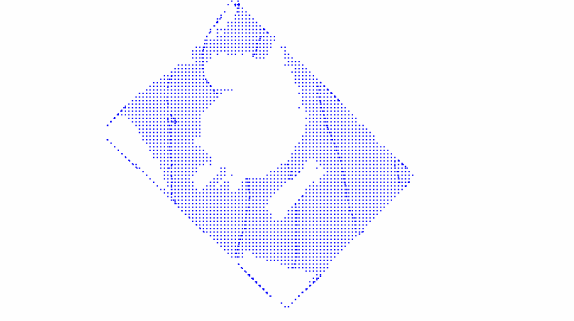
Figure 4: Raw ensemble of inliers, orthogonal projection on the ceiling plane.